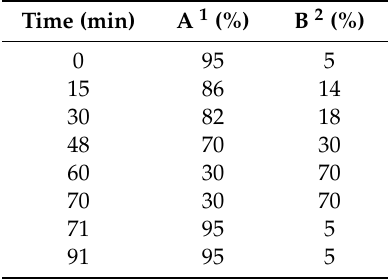
Table 1. HPLC elution program of the binary gradient system for pemetrexed analysis. Time (min) A 1 (%) B 2 (%) 0